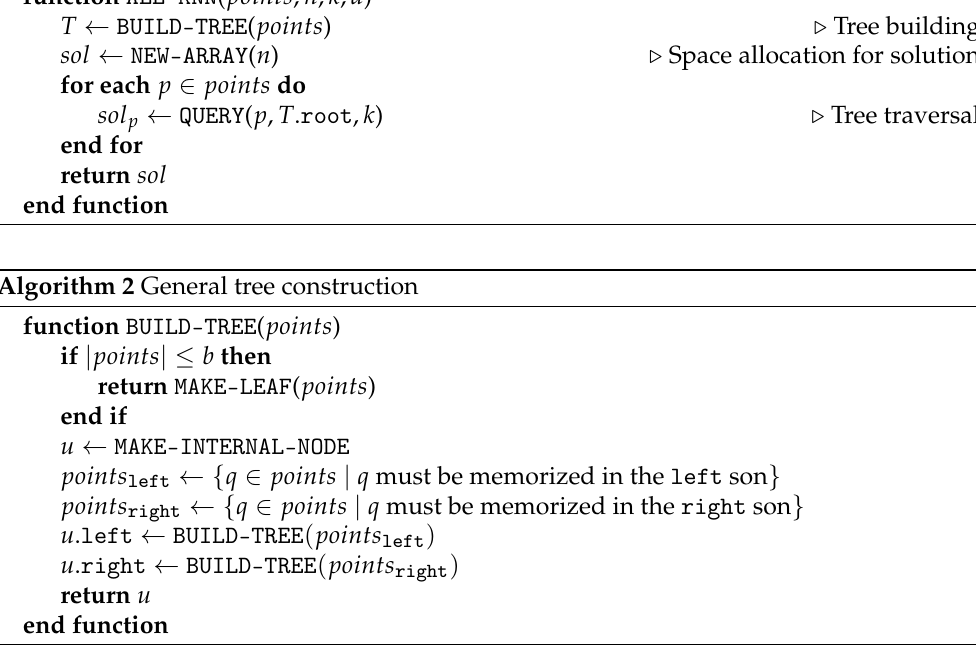
Algorithm 1 General all- k -nn algorithm using a tree structure function ALL-KNN ( points , n , k , d )